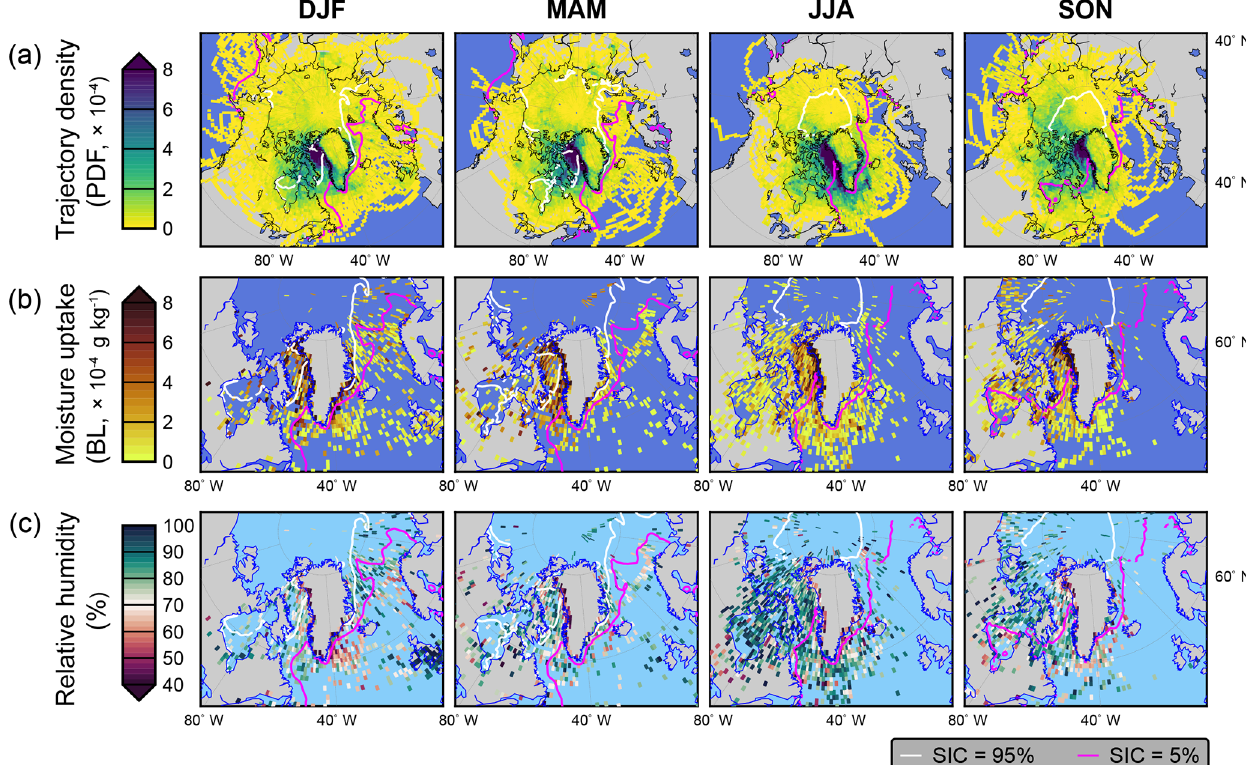
Figure 3. Back-trajectory analysis results for air parcels arriving at Thule for each meteorological season, including (a) trajectory density, (b) regions of water vapor uptake from the boundary layer (BL), and (c) relative humidity for these regions of vapor uptake. Analysis is based on a quasi-climatology that sampled 10 random days from each month during 1980–2018. Trajectory points are binned onto a 1 ◦ latitude/longitude grid as (a) probability density functions (PDF) or (b, c) mean values within each grid cell. White and magenta lines show the extent of 95% and 5% sea ice concentration (SIC), respectively, for the given